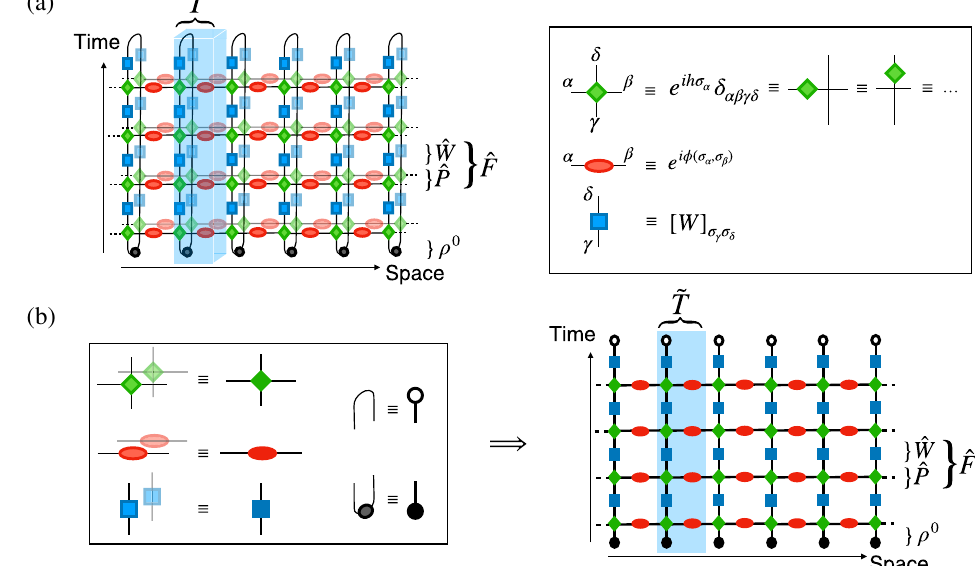
FIG. 2. (a) Graphical circuit representation of the Floquet dynamics of the model in Eq. (2). The periodic unitary time evolution of the initial unentangled density matrix ρ 0 is pictured by a Keldysh closed-time contour made up of a forward and a backward branch. The red ˆ P ˆ W ellipse and blue square tensors represent and unitary operators, respectively. The black tensors denote the initial density matrices of individual spins. For later convenience, we have separated possible phases due to on-site magnetic fields e ih σ denoted by green diamond tensors; the four-index Kroenecker delta tensor δ αβγδ , denoted by a cross, allows us to “ slide ” a green diamond leftward (rightward) or ˆ W ˆ P ˜ T upward (downward), indicating that the field h can be thought of as being part of either or . The dual transfer matrix defined in Eq. (8) is highlighted by a blue shaded region. (b) In the spirit of the Keldysh formalism, the folded picture is obtained by constructing the composite, q 2 -dimensional Hilbert spaces of the forward and backward spins at equal times, spanned by the states fj σ τ j ; ¯ σ τ j ig . The ˆ O ˆ W ; ˆ P local operators acting on this folded space are given by the tensor product of each forward-branch operator ¼ j j þ 1 = 2 and its ˆ O (cid:3) conjugate acting on the backward branch, as illustrated in the left-hand panel. Accordingly, the initial density matrices ½ ρ 0 j (cid:2) σ 0 are ; ¯ σ 0 j j reshaped into vectors ½ ρ 0 j (cid:2) , and the final-time contractions (traces) δ σ t are reshaped into vectors δ , denoted by black and ; ¯ σ t ð σ t j ; ¯ σ t j Þ ð σ 0 j ; ¯ σ 0 j Þ j j white single-leg tensors, respectively; in either case, summation over σ 0 j ; ¯ σ 0 j or σ t j ; ¯ σ t j is implied by tensor